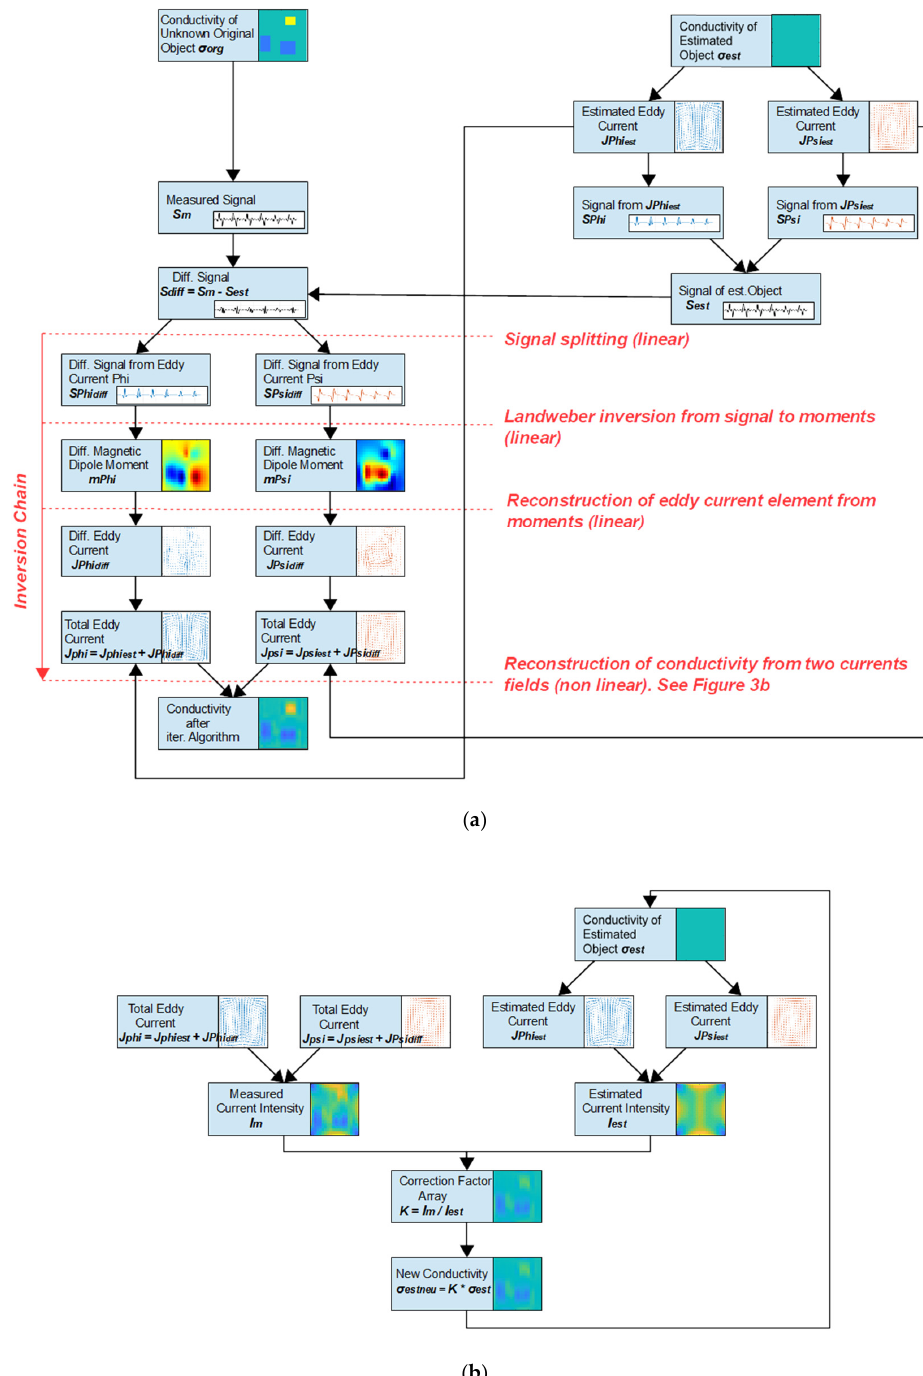
Figure 3. Process schematics. Proposed separation of the MIT inversion chain into a series of non- retroactive, less-demanding, and more insightful subproblems (red descriptions): ( a ) The overall inversion from a measurement (left column) of an unknown object can be relieved with differential MIT (right column): a suitable body estimation can be used to obtain smaller differential signals, which ultimately result in a relatively reduced number of errors and deviations; ( b ) The inversion task from known current fields toward conductivities is a nonlinear and benign task, which is tack- led here with an iterative procedure.